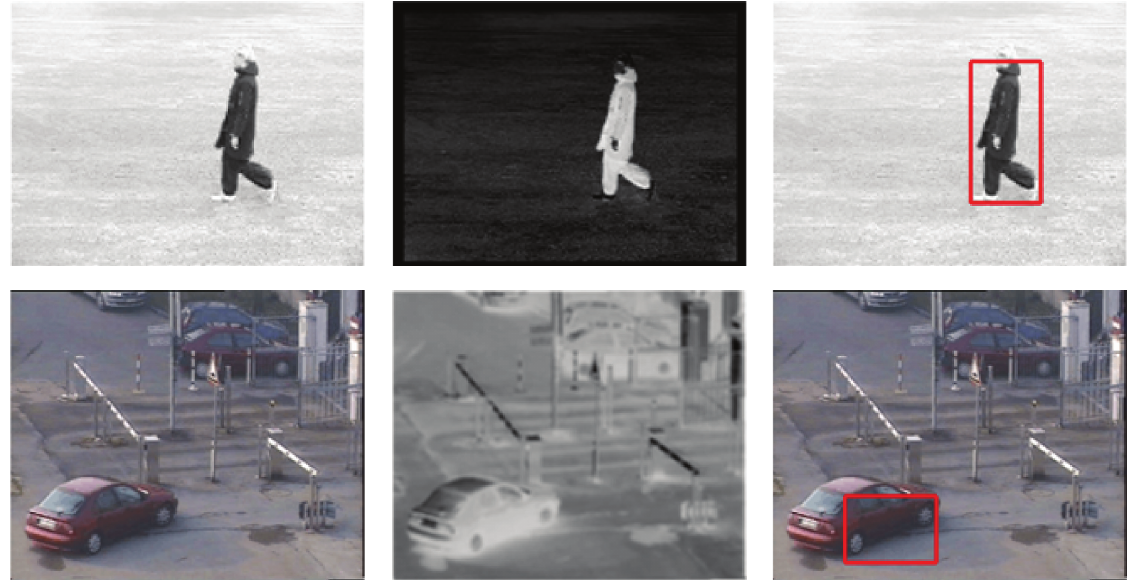
Figure 11: Videos (3) and (4): results using Gaussian spatial model by coalescing Laplacian of Gaussian (LoG) filter and Gaussian filter for different